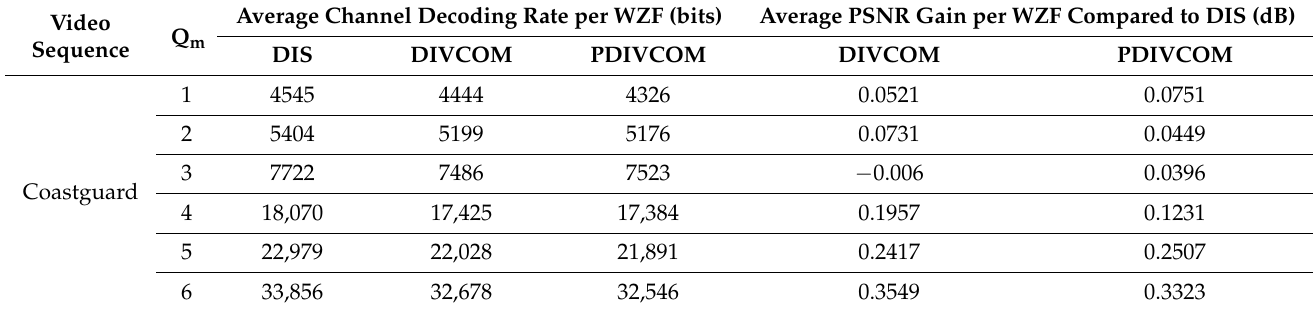
Table 3. Coding efficiency evaluation of proposed novel online CNM for “Coastguard” video sequence.